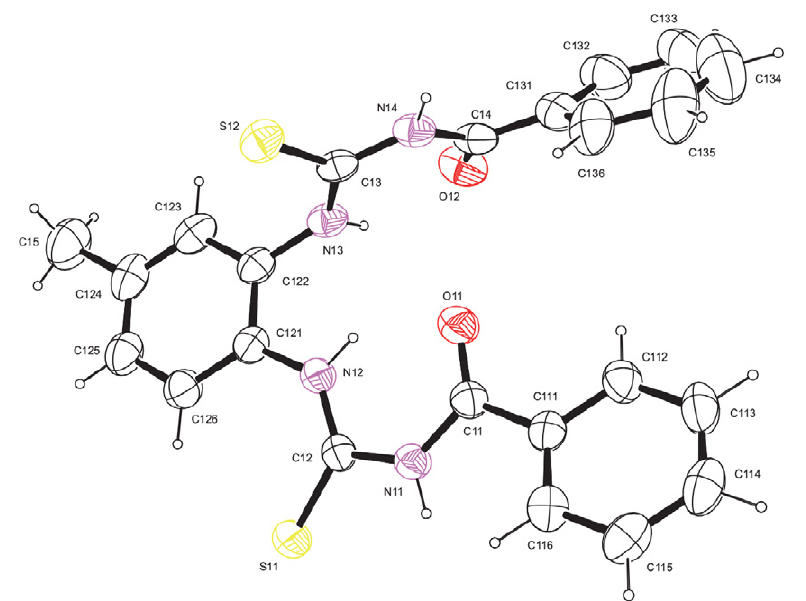
Figure 1. An ORTEP view of 1-benzoyl-3-(5-methyl-2-{[(phenylformamido)methanethioyl]amino}phenyl)thiourea ( 1 ) showing 50% probability displacement ellipsoids and the atom labelling.